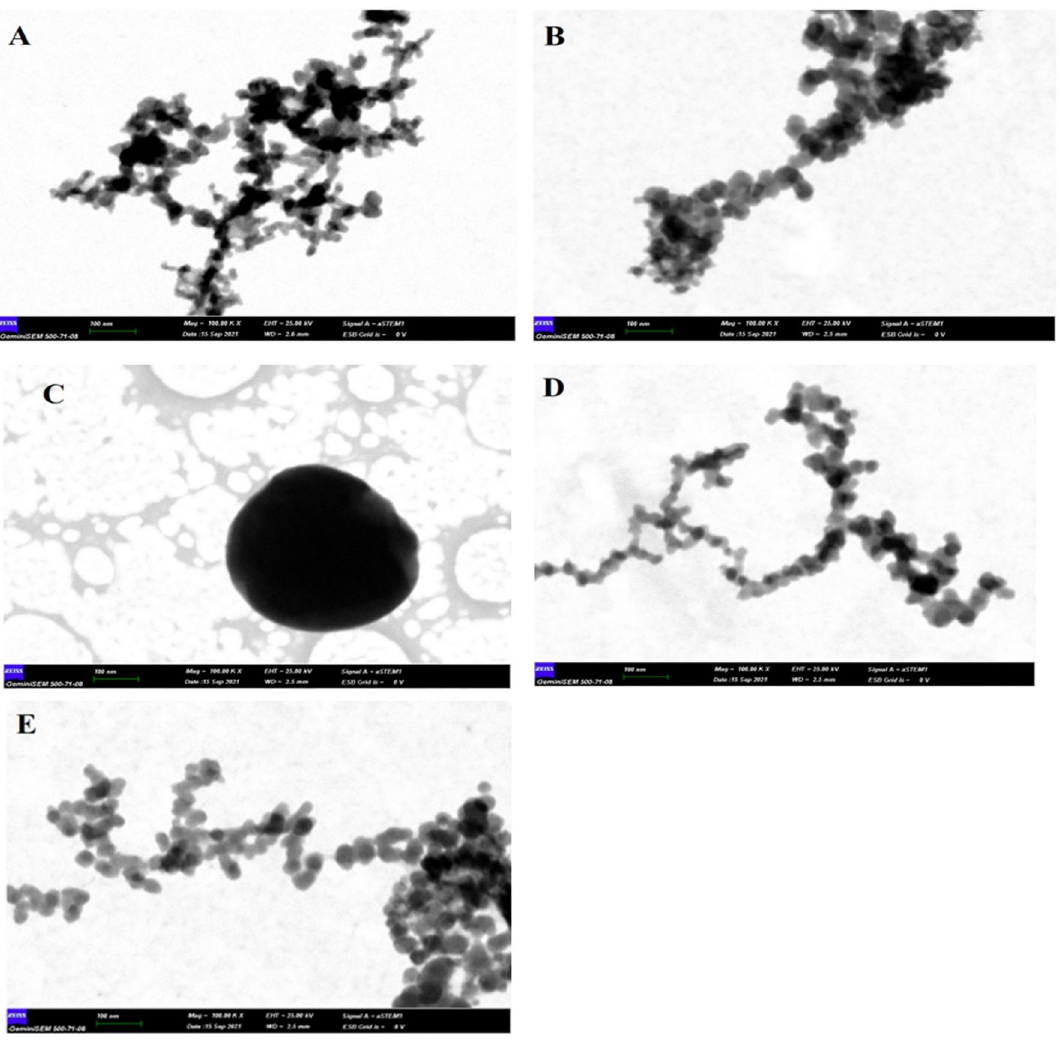
Figure 3. FESEM images of CP-NPs. ( A ) 30 °C, ( B ) 35 °C, ( C ) 40 °C, ( D ) 45 °C, ( E ) 50